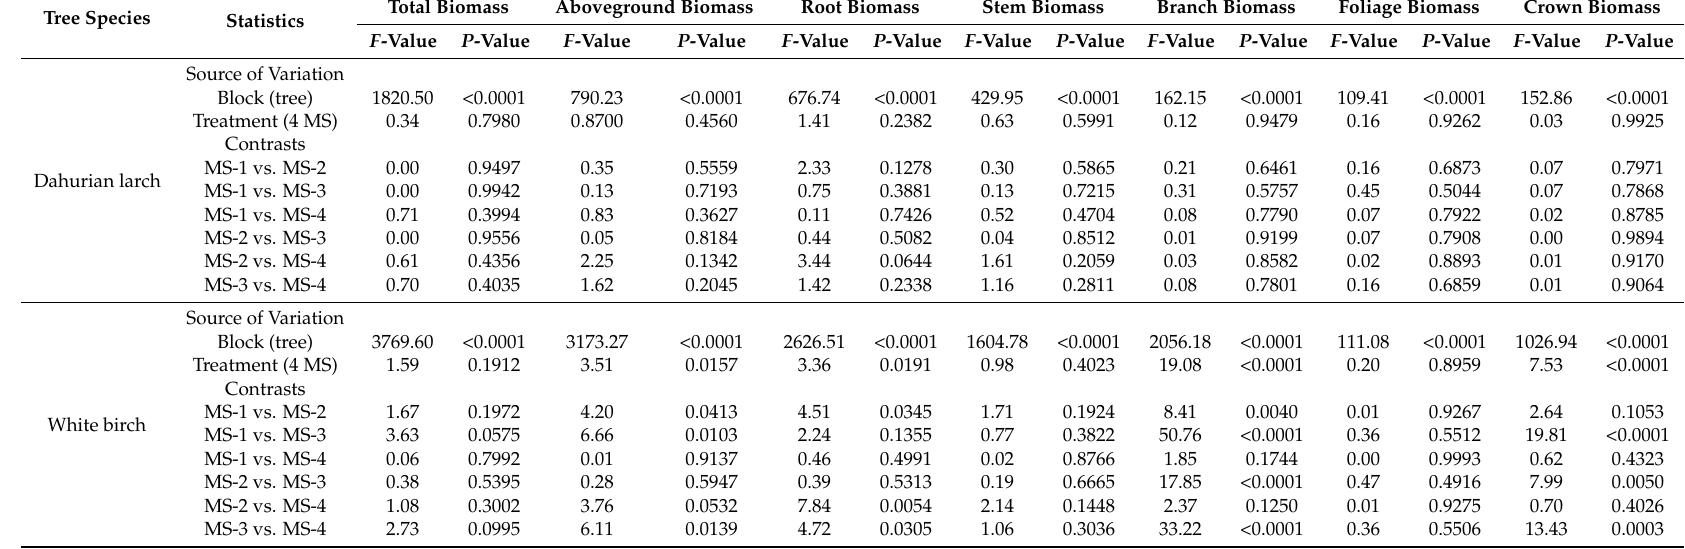
Table 8. Comparison of different additive systems of biomass equations for individual trees of two